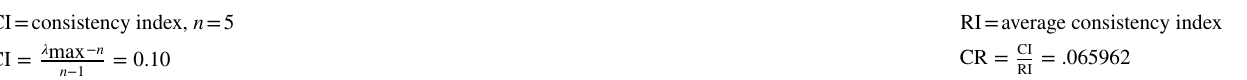
Table 8 CI and CR values CI = consistency index, n =